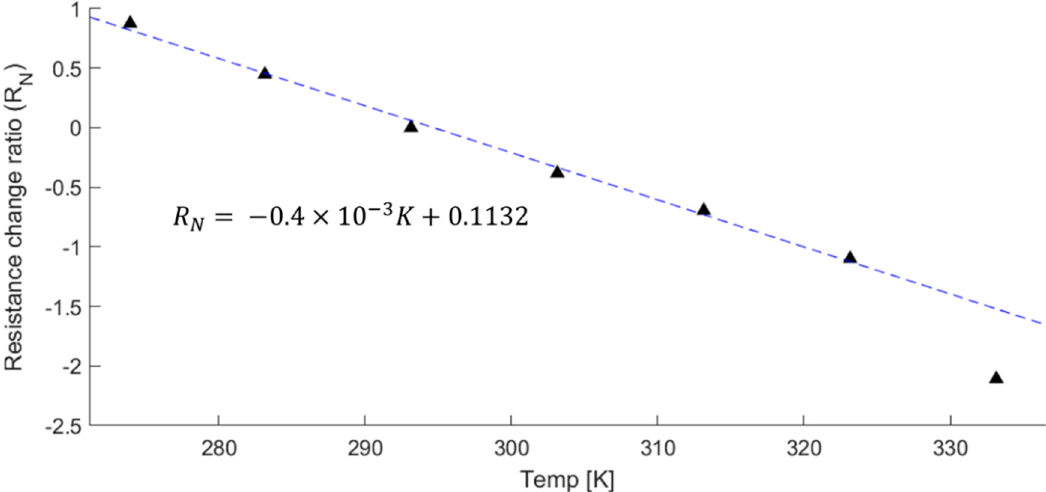
Figure 9. Temperature dependence of the PLC .